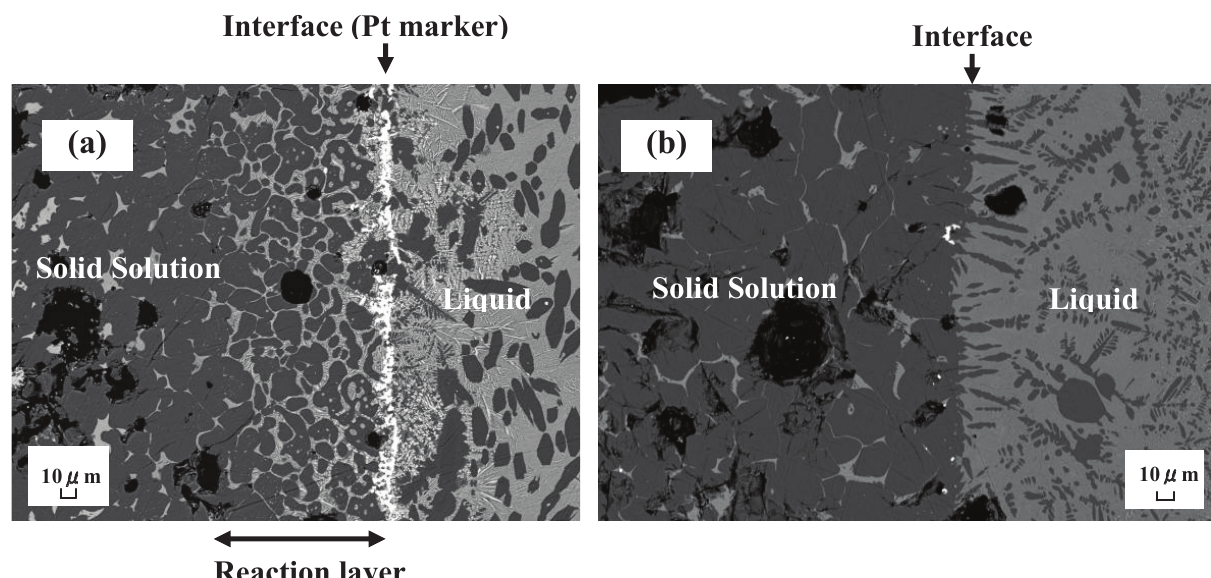
Figure 5. Mineralogical structure of each phase around interface in the cases; (a) when the activity of P 2 O 5 in liquid slag was higher than that in solid solution, (b) when the activity of P 2 O 5 in liquid slag was lower than that in solid so- lution